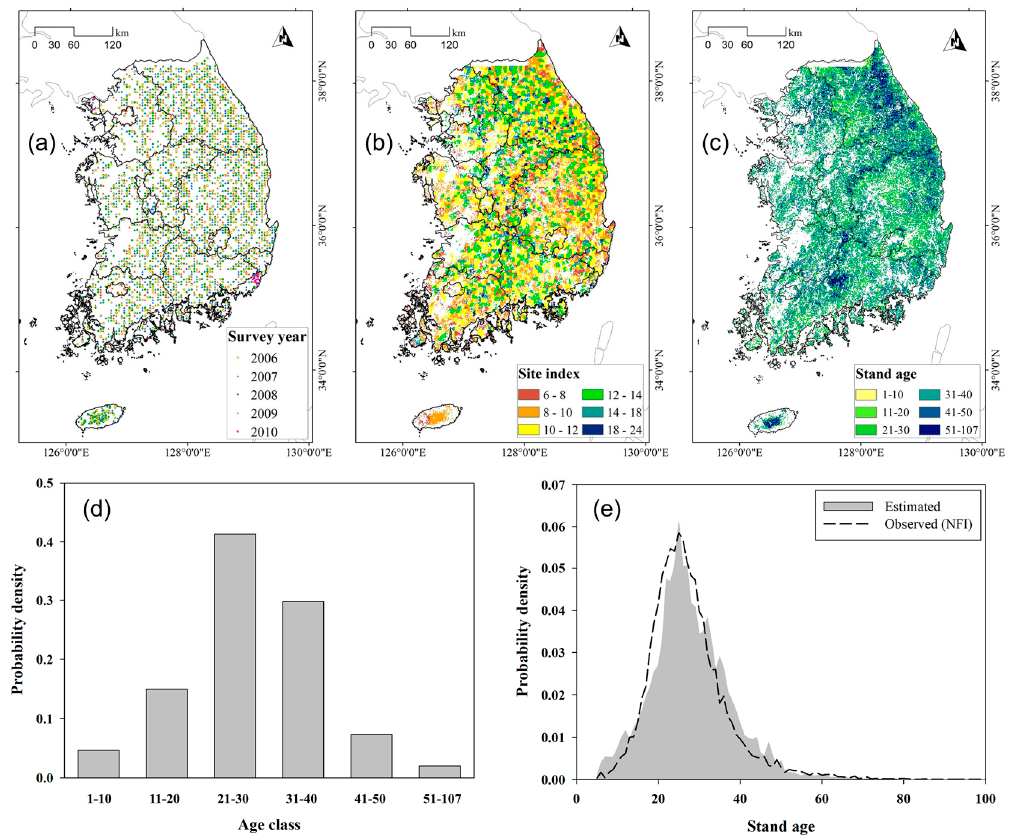
Figure 2. ( a ) Locations of National Forest Inventory (NFI) plots from which data were obtained. ( b , c ) Estimated site index and stand age distribution in 2010 of South Korean forests using the fifth NFI data and 1:5000 forest cover map (FCM). The distribution of ( d ) age classes in the FCM and ( e ) estimated stand age using the FCM and fifth NFI.